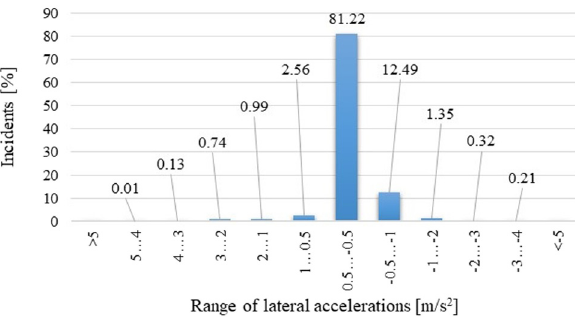
Figure 15: The frequency of occurrence of particular values of long - itudinal acceleration for selected sections of the route – morning